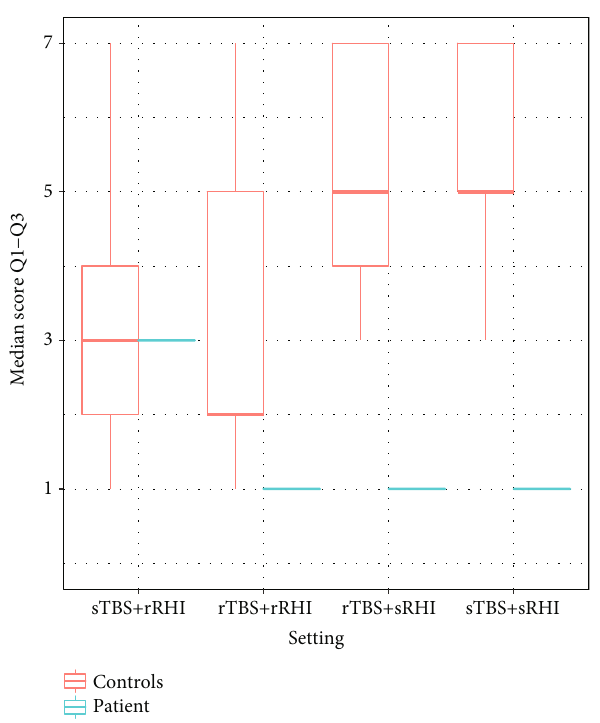
Figure 6: Comparison of the median of the fi rst three questions (Q1-3), between the patient and the healthy control group in score points. rRHI: real rubber hand illusion; sRHI: sham rubber hand illusion; rTBS: real theta burst stimulation; sTBS: sham theta burst stimulation. Table 4: Summary of all results for the patient and the control group. ppd EPT Questionnaires Condition